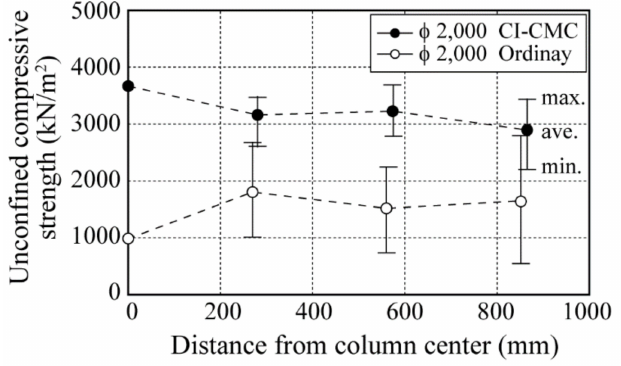
Figure 11. Stabilized soil strength distribution within the column [16].